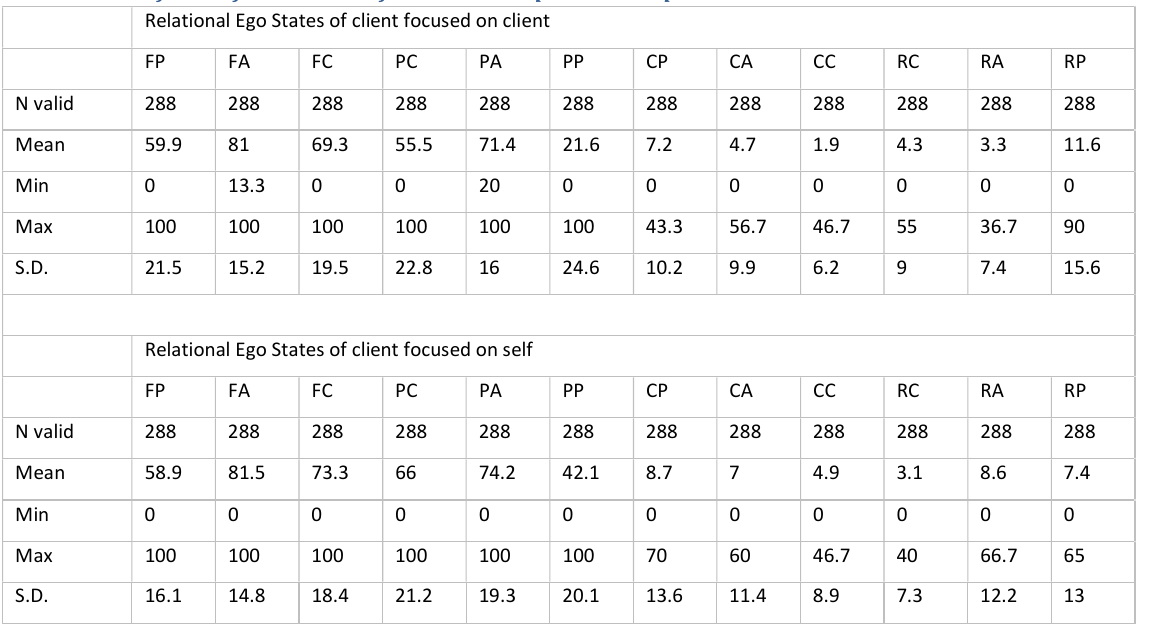
Table 2: Descriptive statistics of 12 Relational ES of the therapist focused on the client and 12 Relational ES of client focused on self in relationship with therapist